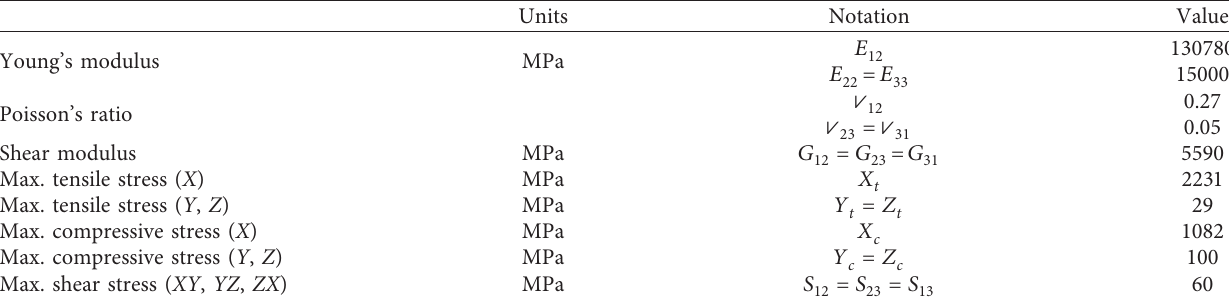
Table 4: FE analysis (input data) (Yosri et al.